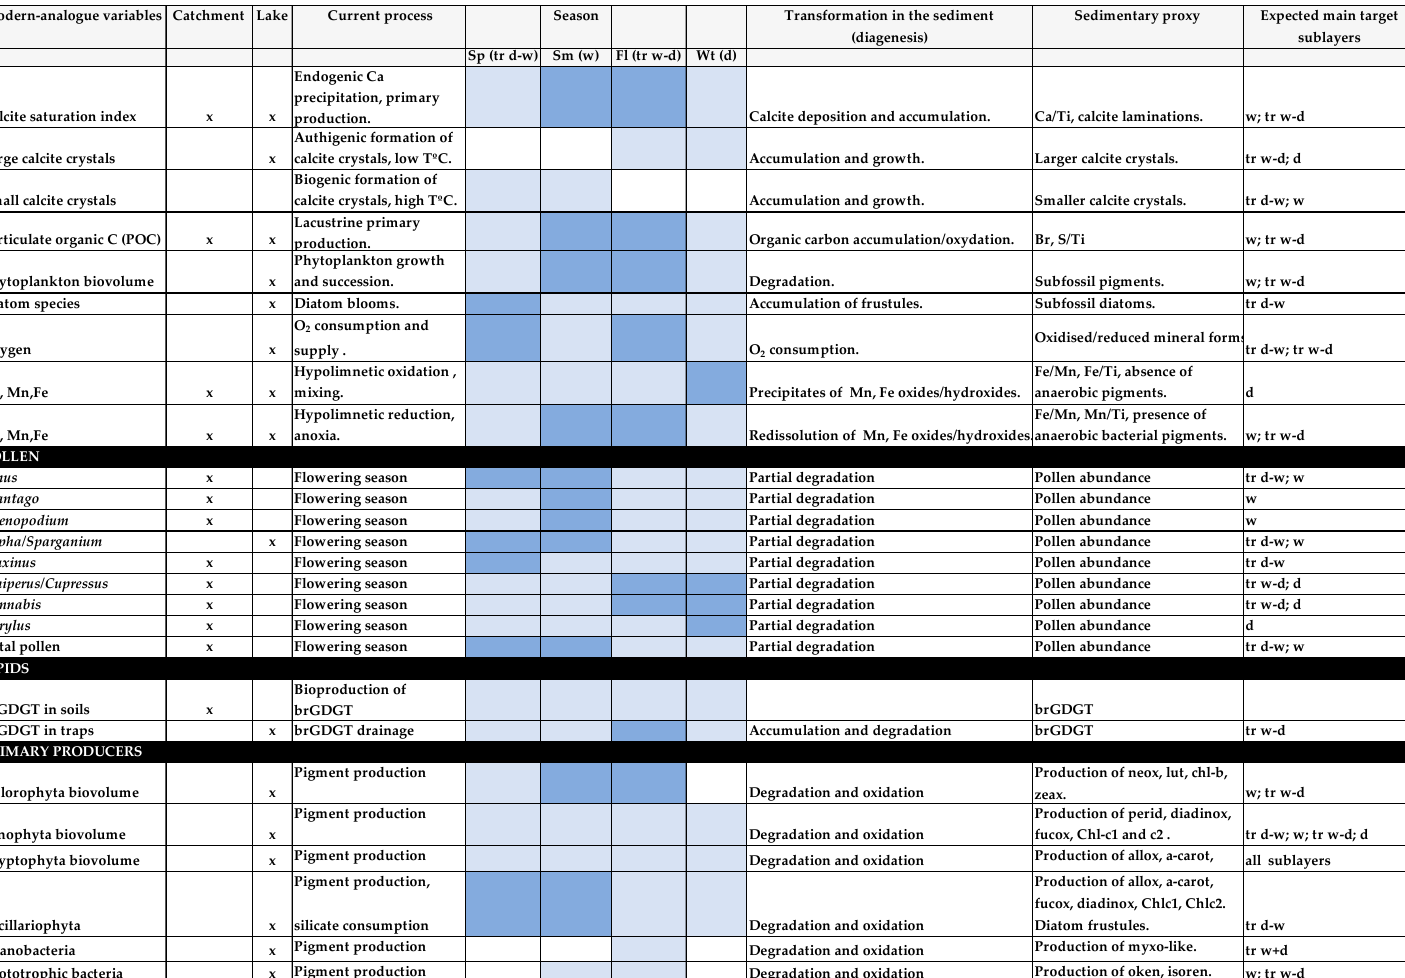
Figure 10. Synthesis of main modern analogue variables and processes at Lake Montcortès, derived proxies and their expected target sublayers. White (w); dark (d): white-dark transitions (w-d tr) and dark-white transitions (d-w tr) between sublayers. Sp: spring, Sm: summer, Fl: Fall, Wt: winter.